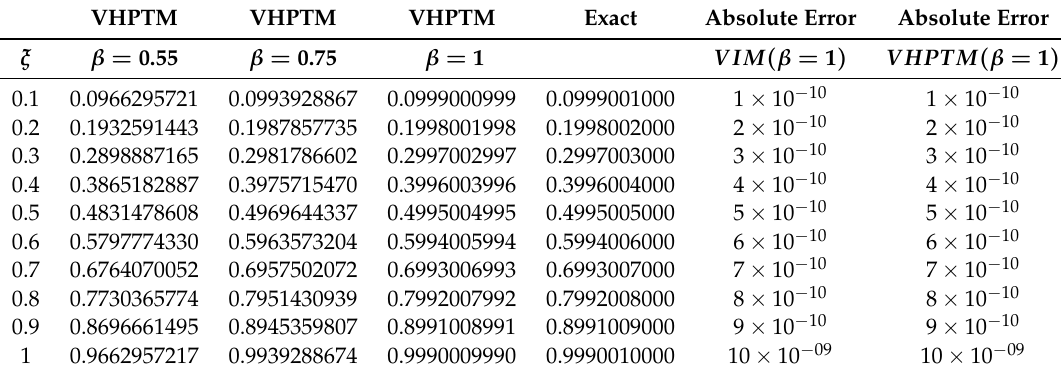
Figure 2. Variational homotopy perturbation transform method solution of example 4.1 at different fractional order β = 1, 0.8, 0.6, 0.4. Table 1. Comparison of VHPTM and variational iteration method (VIM) [19] of example 1 at η =